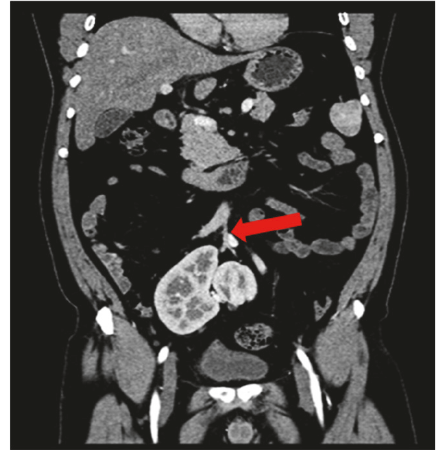
Figure 2: Coronal CT scan with IV contrast showing the median sacral artery (red arrow) giving right and left renal arteries.